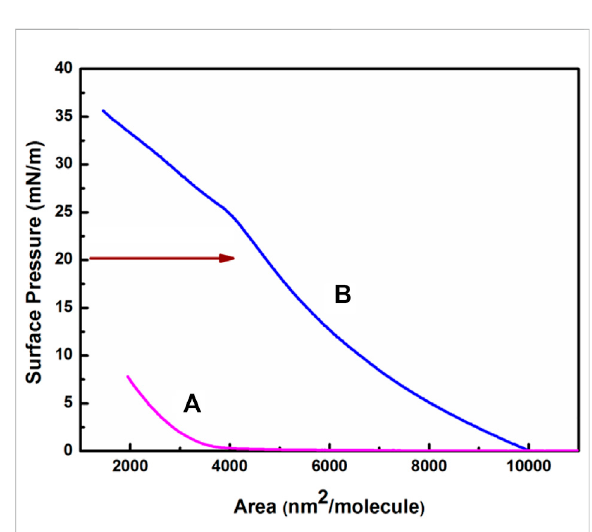
FIGURE 2 Room temperature ( π ) − (A) isotherm of HC-Ct DNA atthe air- water interface recorded after spraying in the LB trough for (A) 10 min and (B) 8